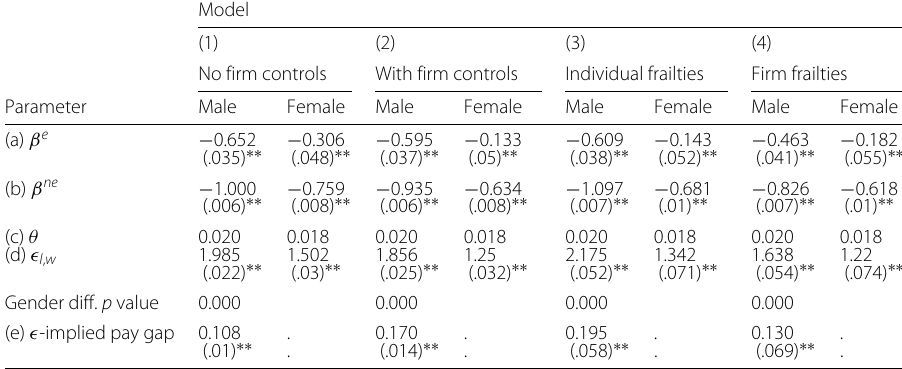
Gender diff. p value 0.000 0.000